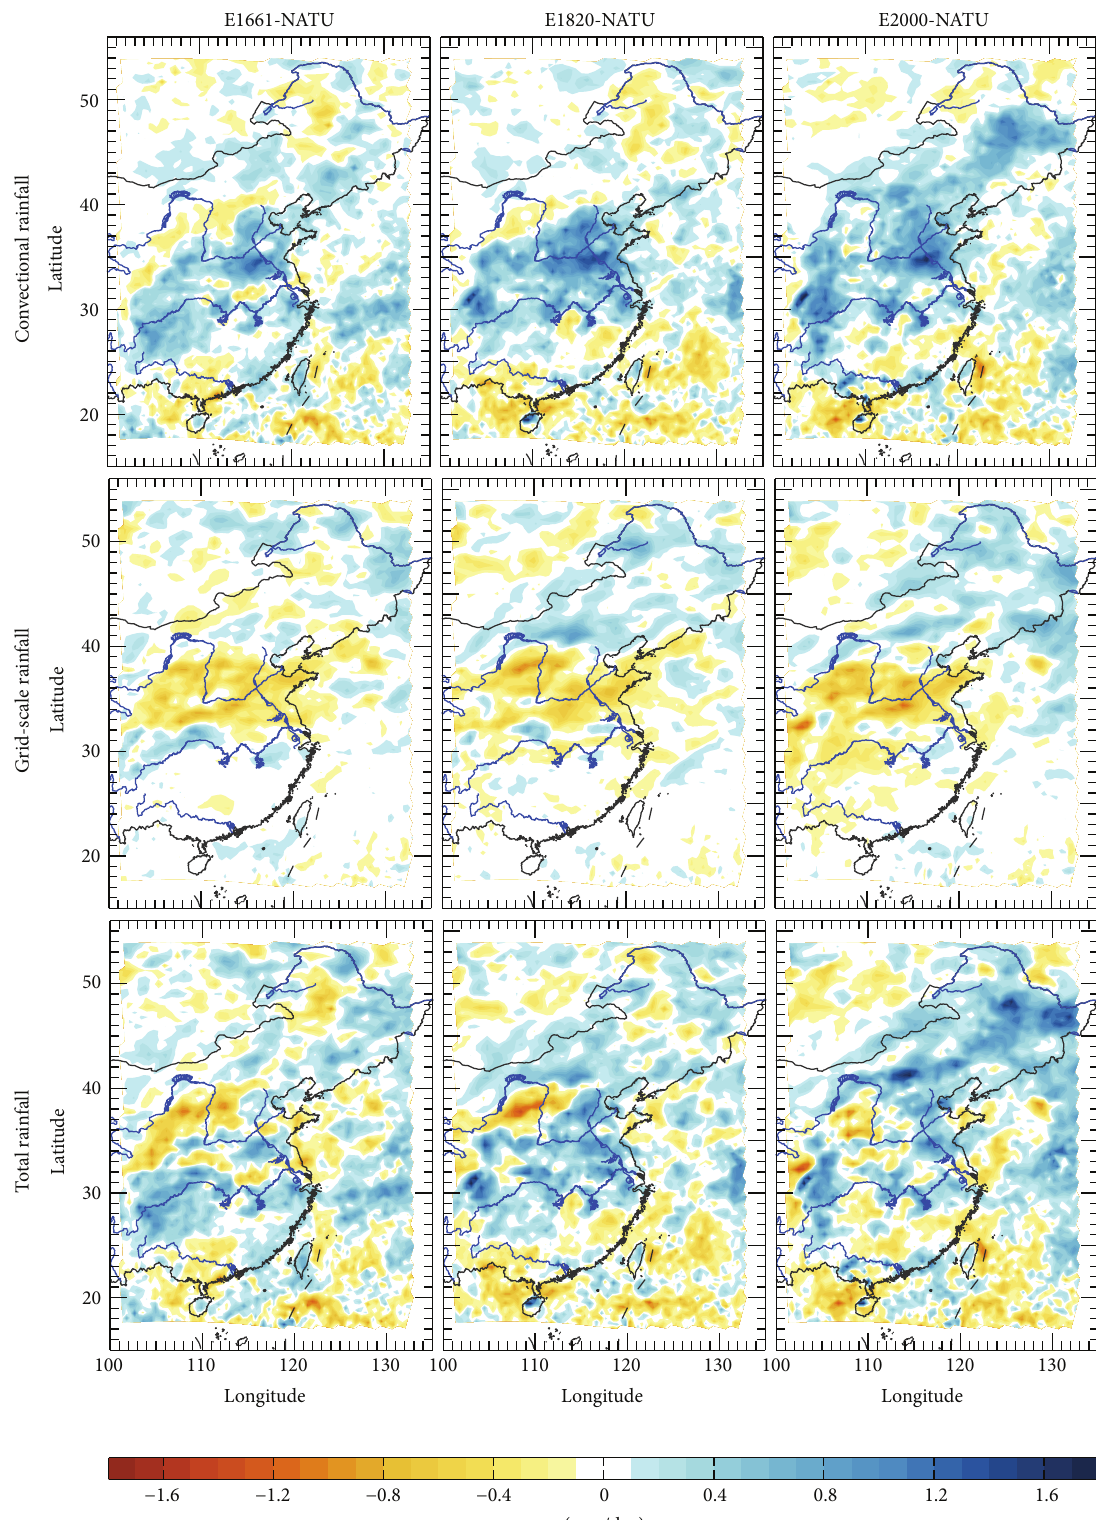
Figure 4: Changes in convective rainfall, grid-scale rainfall, and total rainfall induced by land cover conversions from natural vegetation to cropland in 1661, 1820, and